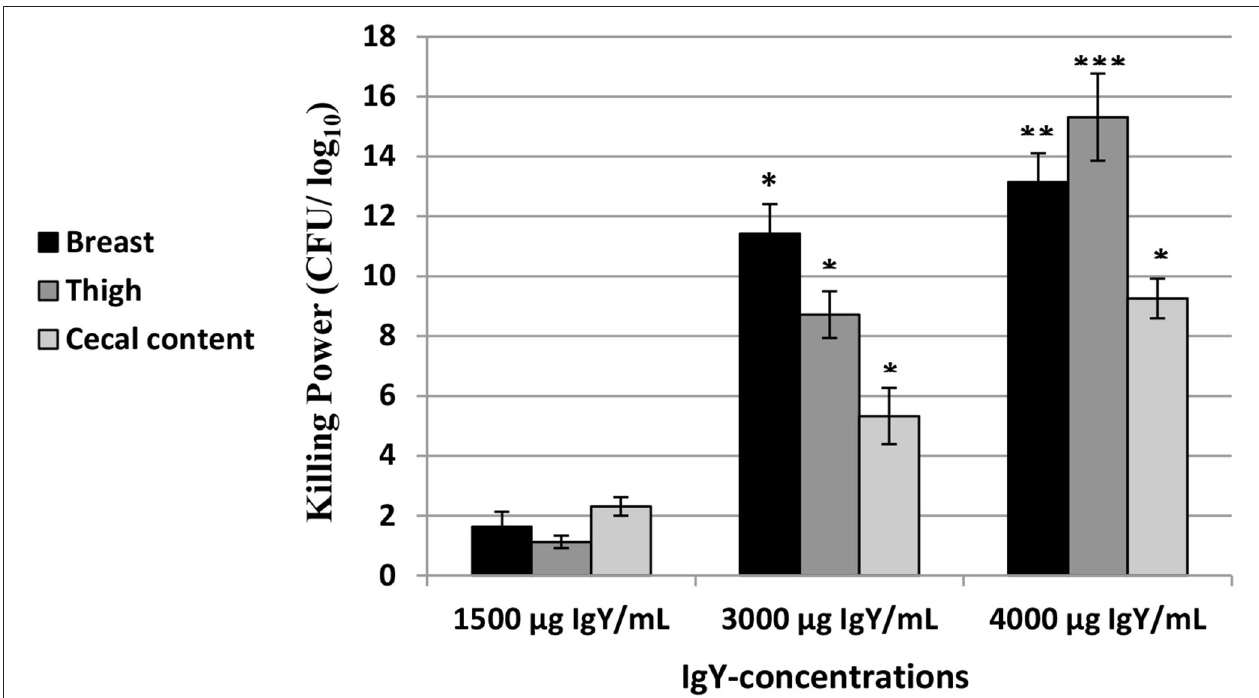
FIGURE 2 | Log 10 of the antibacterial activity (mean ± SEM) of the immunoglobulin Y (IgY) concentrations (1,500,3,000,and 4,000 µ g/ml) in the breast,thigh,and cecal content of chicken against Escherichia coli . * p < 0.05,** p < 0.01,*** p < 0.001 (compared to 1,500 µ g/ml IgY).